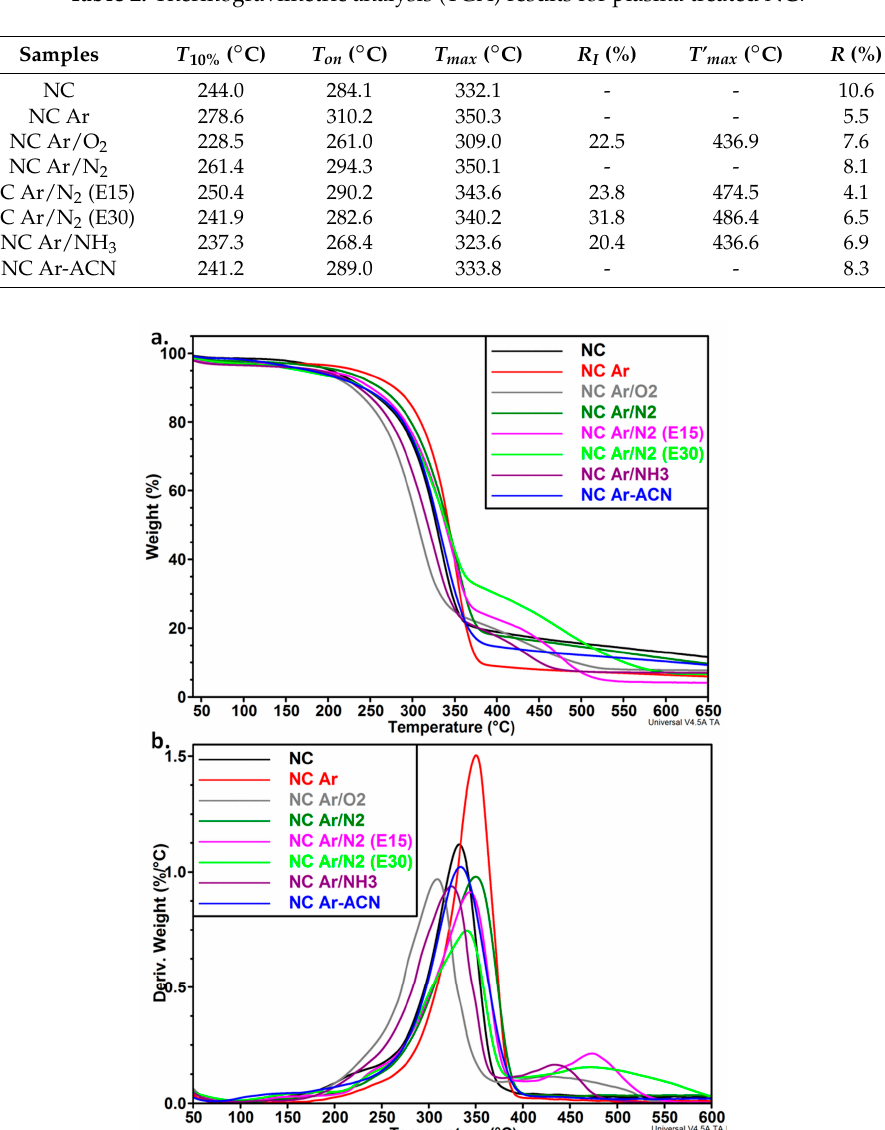
Figure 6. Thermogravimetric analysis (TGA) spectra ( a ) and derivative thermogravimetric (DTG) overlapped curves ( b ) of plasma treated NC.